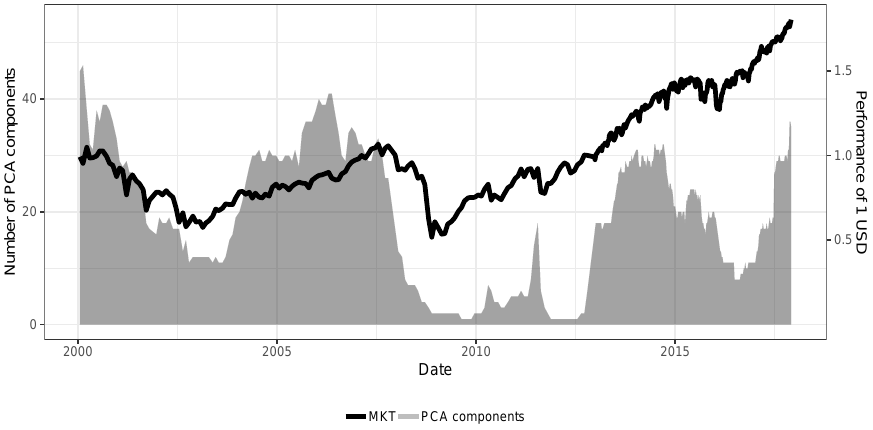
Figure 4. Number of required principal components to explain 90% of S&P 500 constituents return variation and S&P 500 index performance (MKT) from January 2000–December 2017. Source: authors’